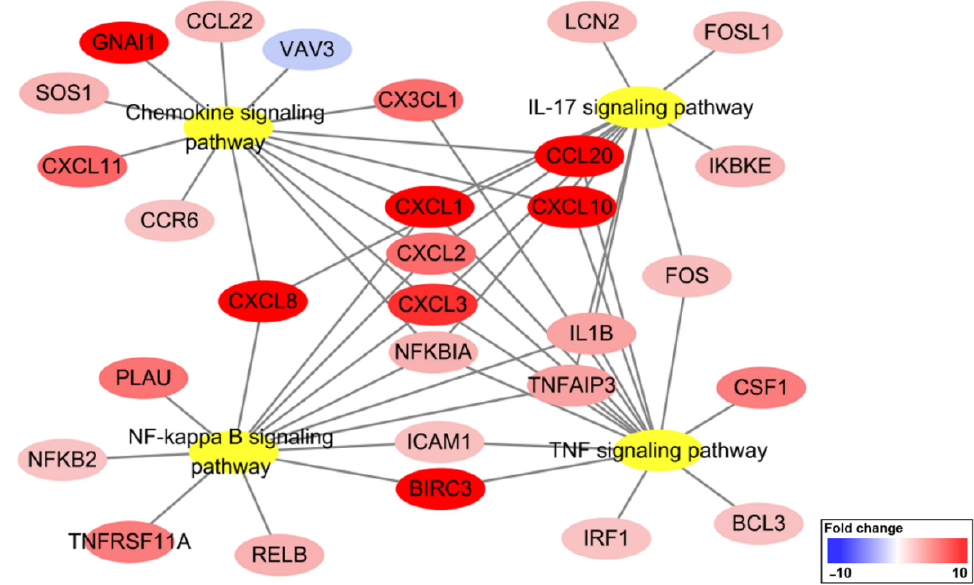
Figure 5. Network visualization of top four KEGG pathways and genes enriched in CotG-p75 stimulated Caco-2 cells. Yellow circles represent KEGG pathways. Red and blue circles represent the enriched genes colored according to their fold change values. Fold change value is expressed based on the color key.